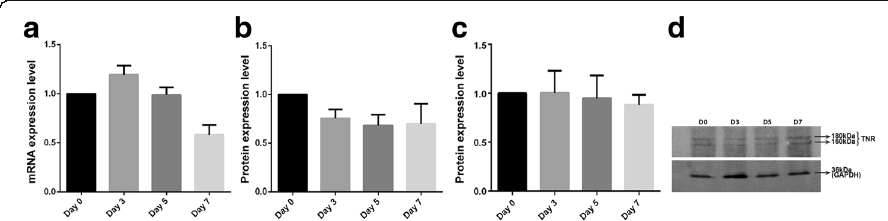
Fig. 3 The expression analysis of TNR during differentiation at the mRNA level ( a ) and the protein levels for TNR-160 kDa ( b ) and TNR-180 kDa ( c ). Representative western blot analysis of TNR protein ( d ). mRNA levels were normalized against the PPIA gene. GAPDH was used as a loading control in western blot